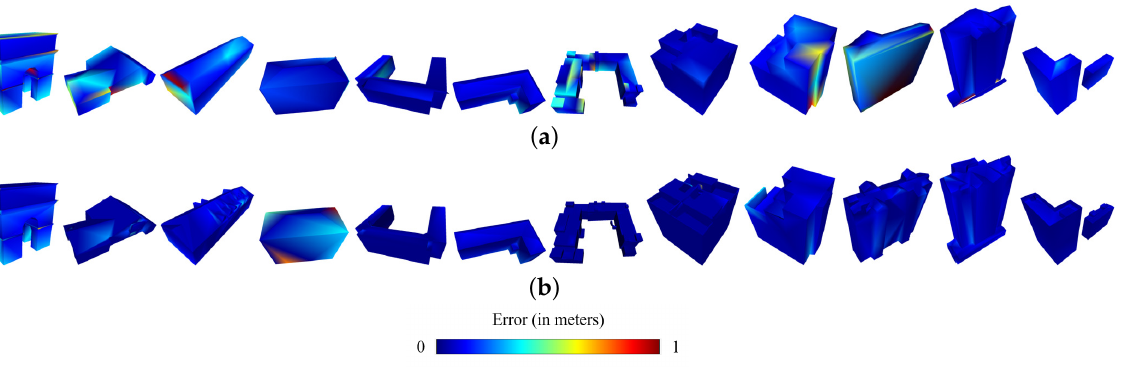
Figure 17. Comparison with SABMP [11] of Hausdorf f distance : ( a ) SABMP [11] and ( b )